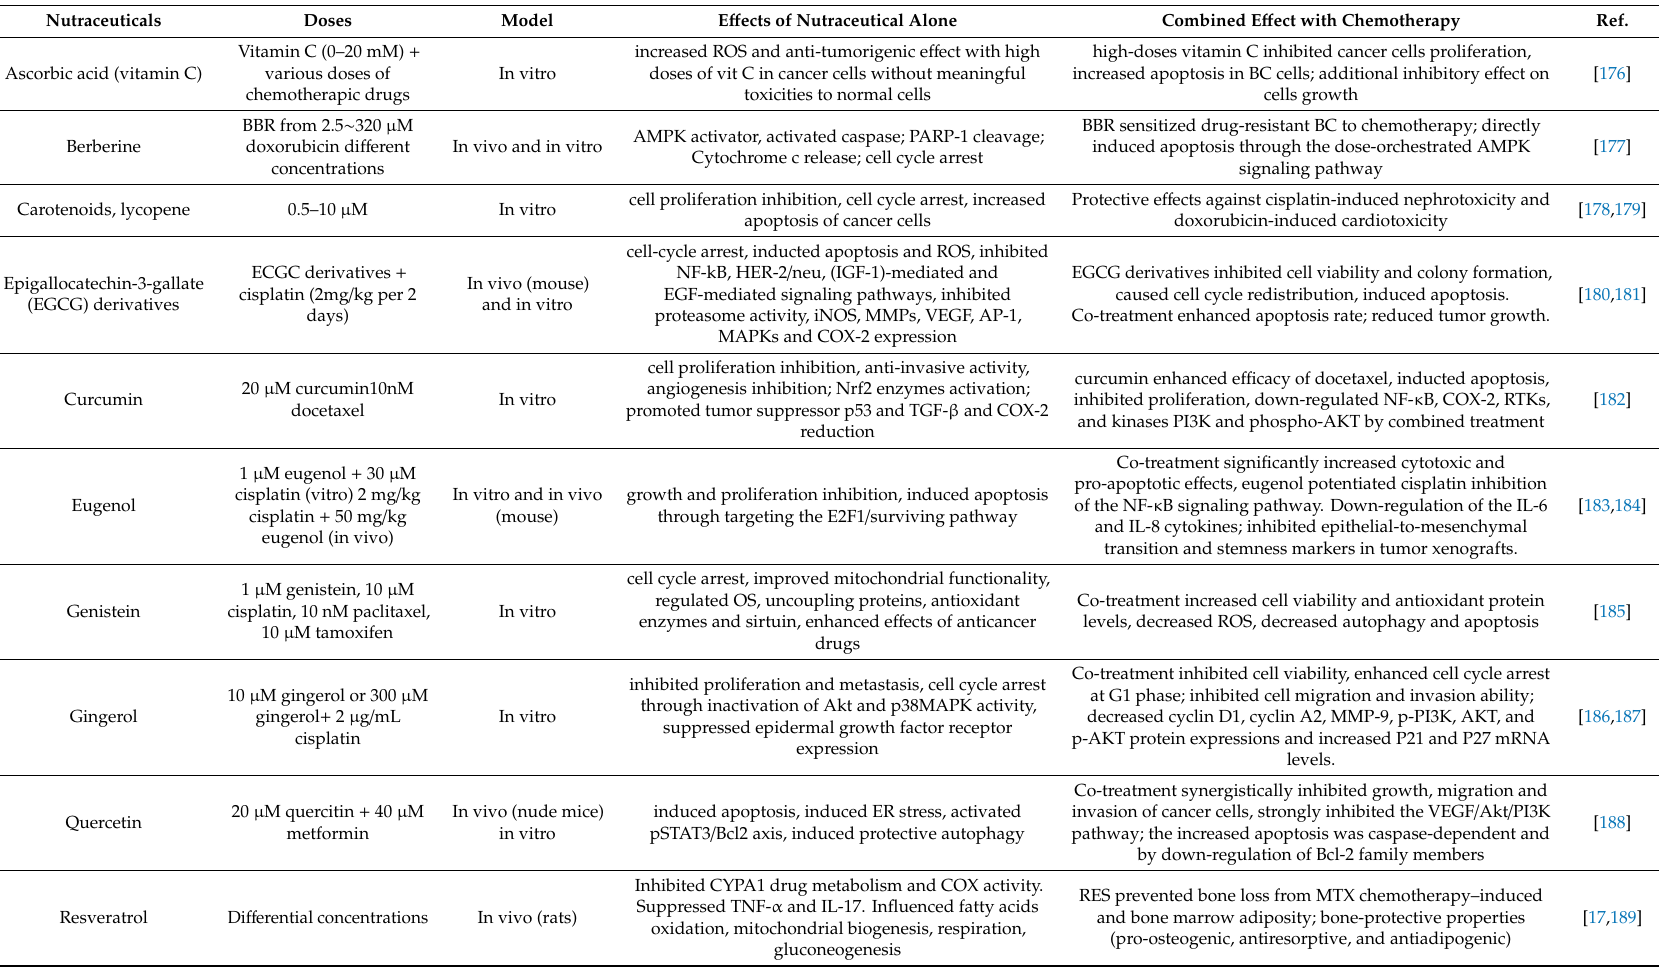
Table 1. Experimental studies of di ff erent nutraceuticals alone and combined with